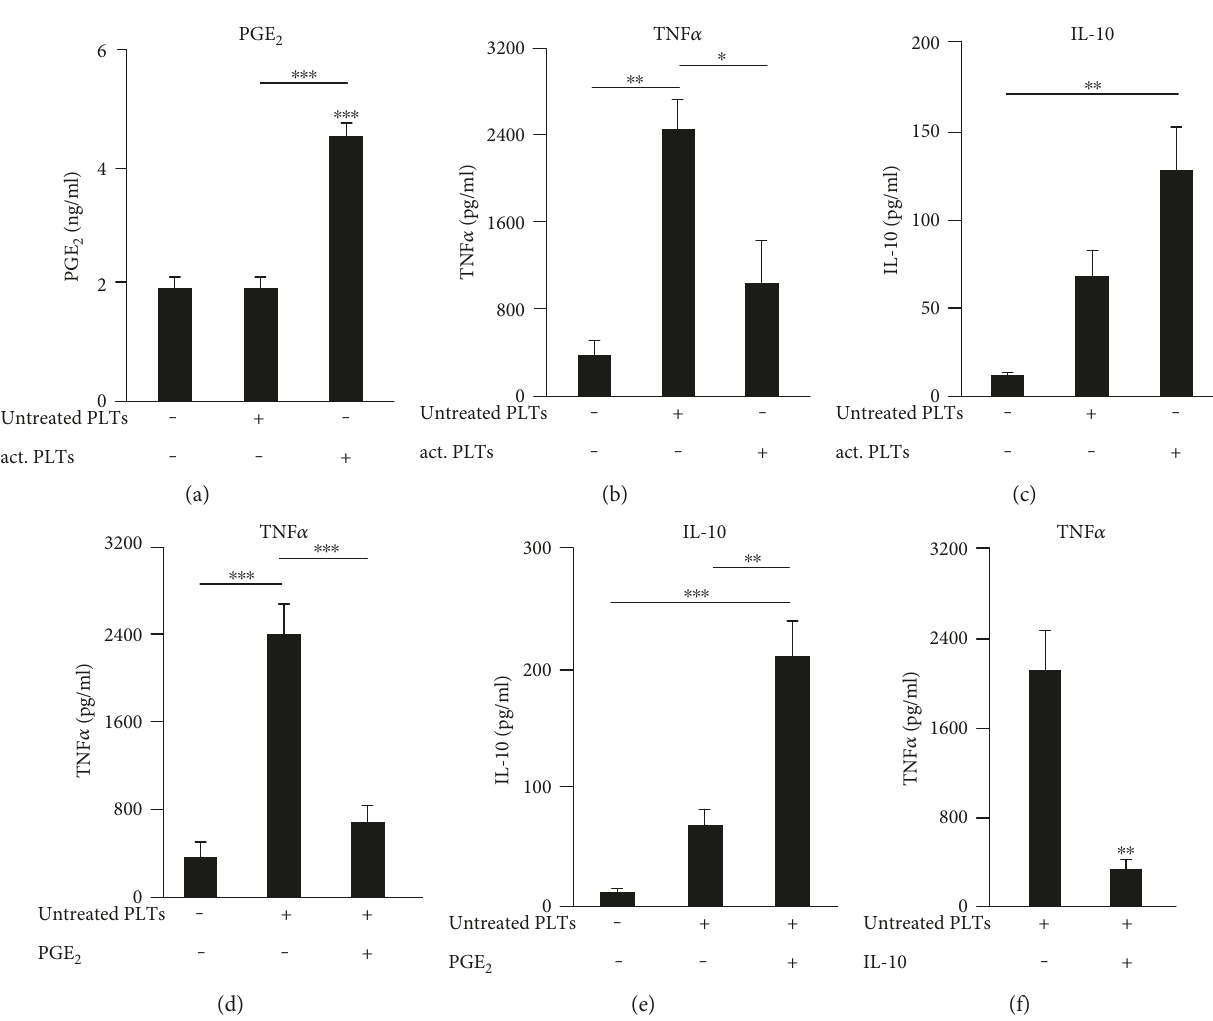
Figure 6: PGE mediates inhibition of TNF α release from platelet-stimulated human monocytes. (a), (b), (c) Human monocytes were 2 incubated alone, with untreated human platelets or with collagen-activated human platelets for 3 hours and PGE (c) were determined. (d), (e) Human monocytes were incubated alone or with untreated platelets with or without PGE Human monocytes were incubated with untreated platelets with or without human IL-10 (125pg/ml). The concentrations of PGE and IL-10 within the cell-free supernatants were determined by LC-MS/MS or rather ELISA within cell-free supernatants. Data are presented as mean ± SEM from 4 experiments. One-way ANOVA/Bonferroni (a) – (e) or two-tailed t -test (f) ∗ P < 0 05 , ∗∗ P < 0 01 , ∗∗∗ P < 0 002